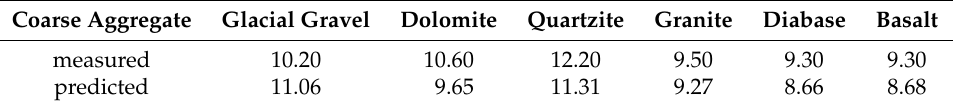
Table 8. Comparison of the model predicted with the experimentally measured thermal expansion coefficients by Naik et al. [37] for concretes with different types of coarse aggregates (unit: 10 − 6 / ◦ C).